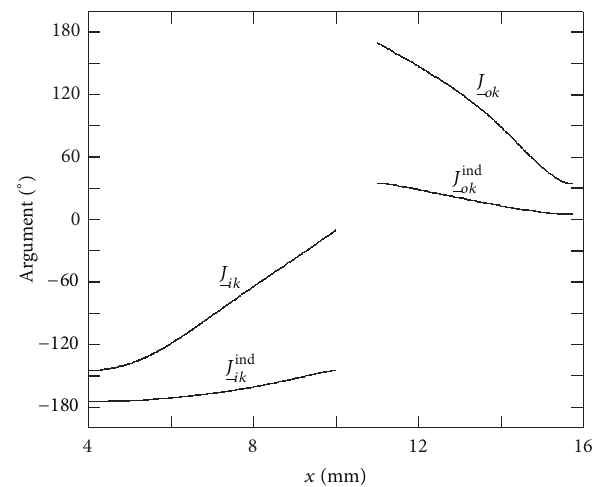
Figure 3: Dependence of phasor argument of resultant current and of phasor argument of induced current density 𝐽 ind density 𝐽 on distance 𝑐𝑘 𝑐𝑘 on distance from axis of conductors in Example 1, for 𝑓 = 10 3 Hz, 𝑛 = 1000 ̂𝐽 sou = 2.842 × 𝑖𝑘